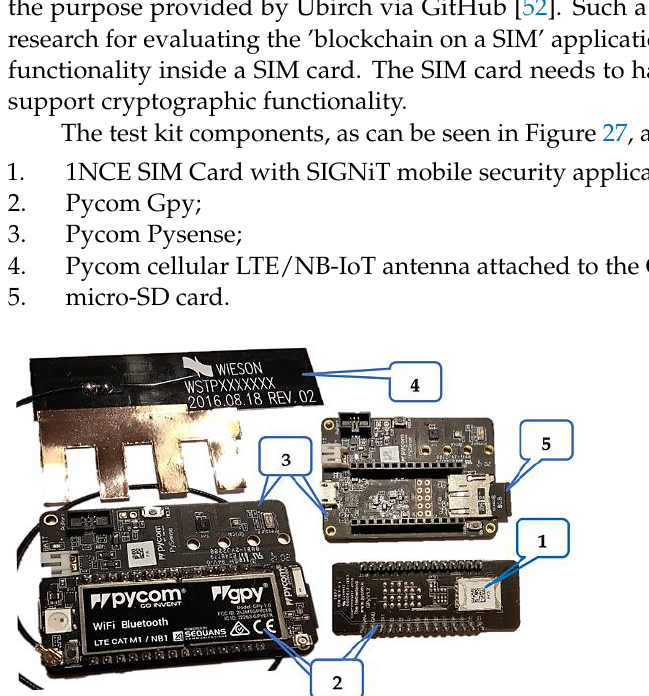
Figure 28. Enrolling NB-IoT device with authentication keys and corresponding backend services. The Testkit will create an apiConfig text file on the SD card, which contains the unique IMSI of the SIM card as well as the following elements: •